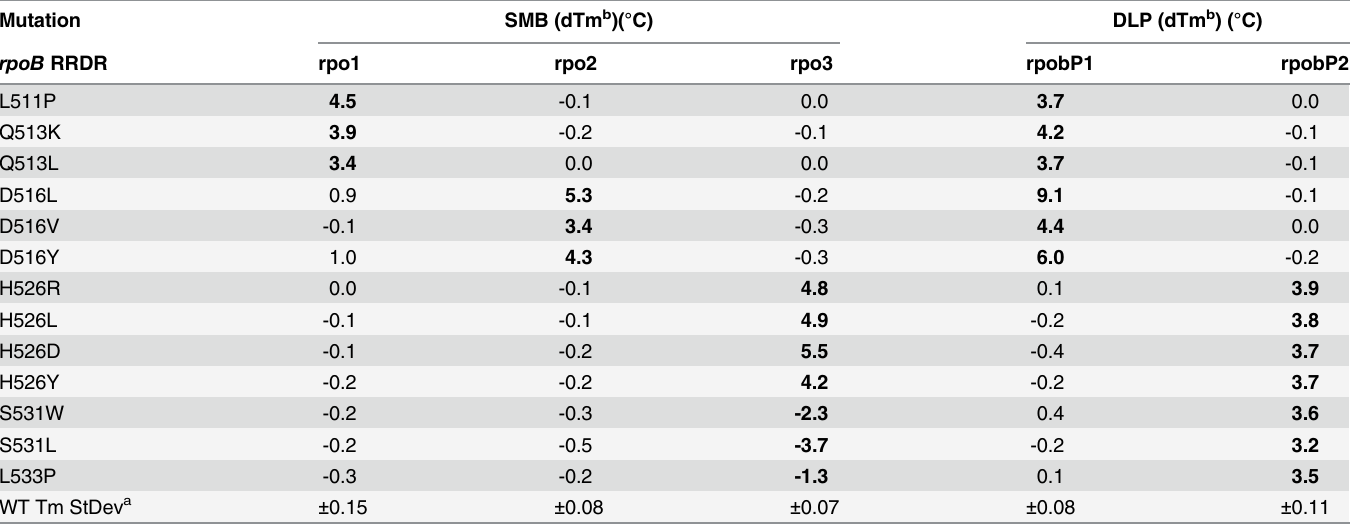
Table 1. Average dTm values for mutations tested by both DLP and SMB rpoB assays.